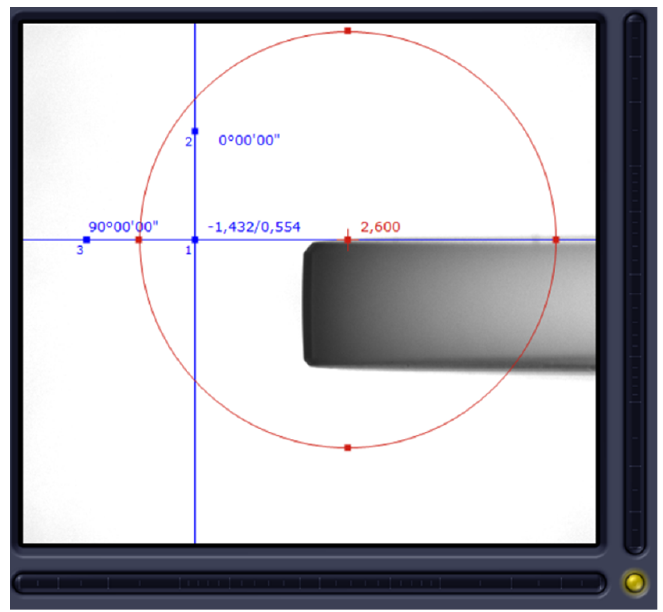
Figure 15. Example of T5 probe error investigation. Disc styli visual valuation on the tool pre-set-